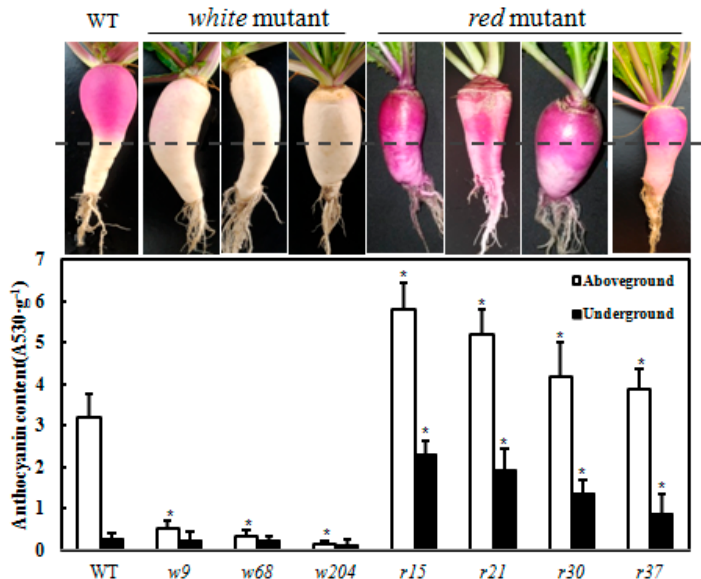
Figure 3. Characterization of light-independent anthocyanin mutants. Phenotypes of the WT and mutants isolated in M 2 population are shown. White mutants with anthocyanin deficiency ( w9 , w68 and w204 ); Red mutants with anthocyanin over accumulation in the epidermis of swollen storage roots ( r15 , r21 , r30 and r37 ). The swollen roots under dash line were covered by soil, while the parts above dash line were exposed to sunlight. Total anthocyanin content in mutants and WT were measured. The white columns, aboveground part of epidermis of swollen roots; black columns, underground part of epidermis of swollen roots. The data represent mean values from three replicates with biological repeats ( n ≥ 3). Error bars represent the standard error of the mean. “*” represents significantly differences at the level of p < 0.01.